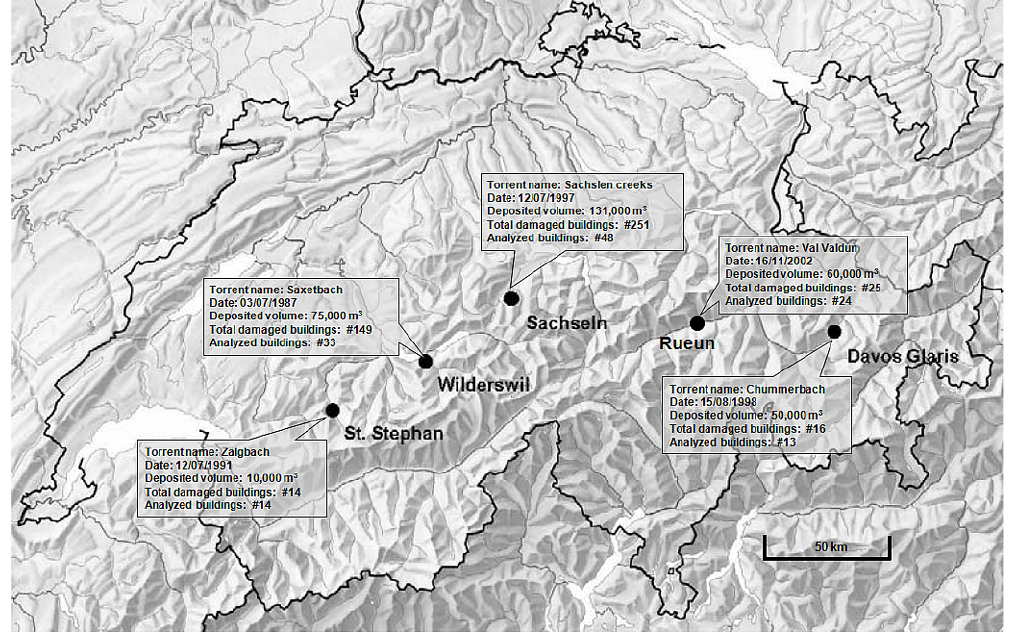
Fig. 2. Summary of the analyzed hazard sites including information about the location, date, total debris volume, and number of affected and of analyzed buildings. © Federal Office of Topography